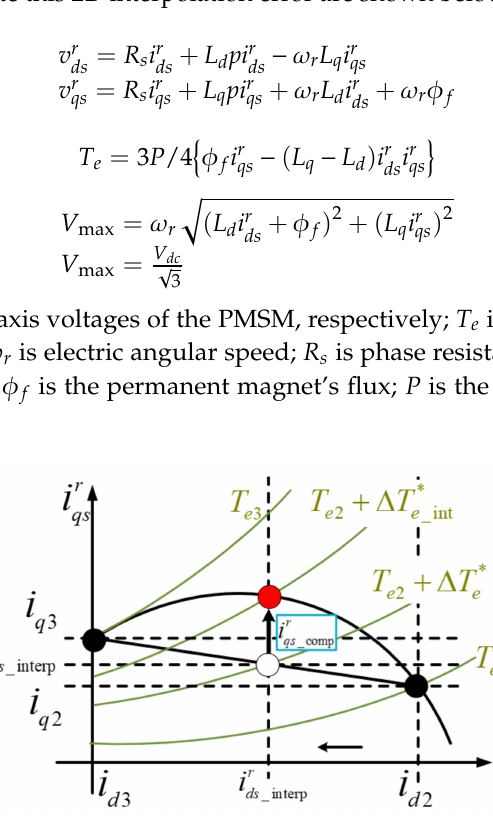
Figure 4. Magnified 2D interpolation error in field weakening region of Figure